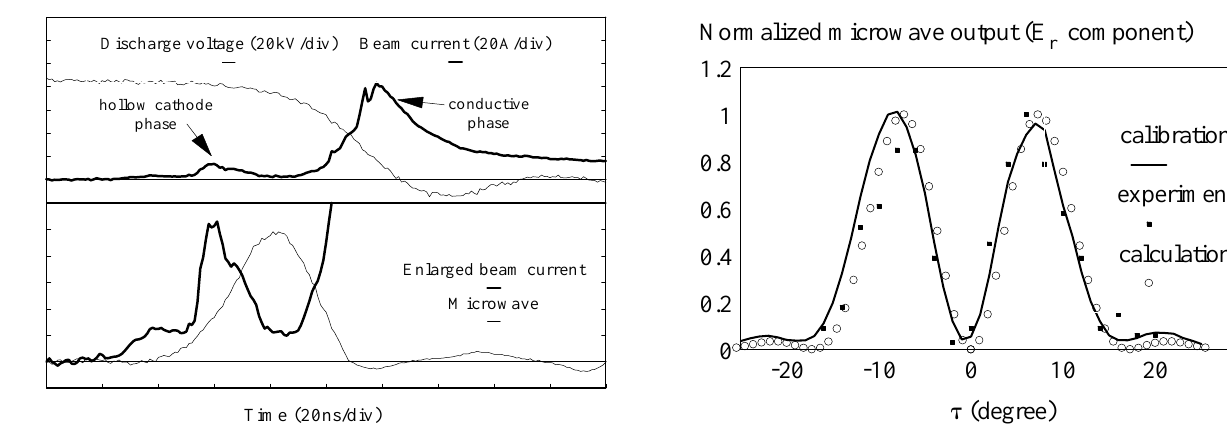
FIG. 4. Far-field mode pattern scan of the radial component (cid:69) (cid:114) compared with a calculation and bench